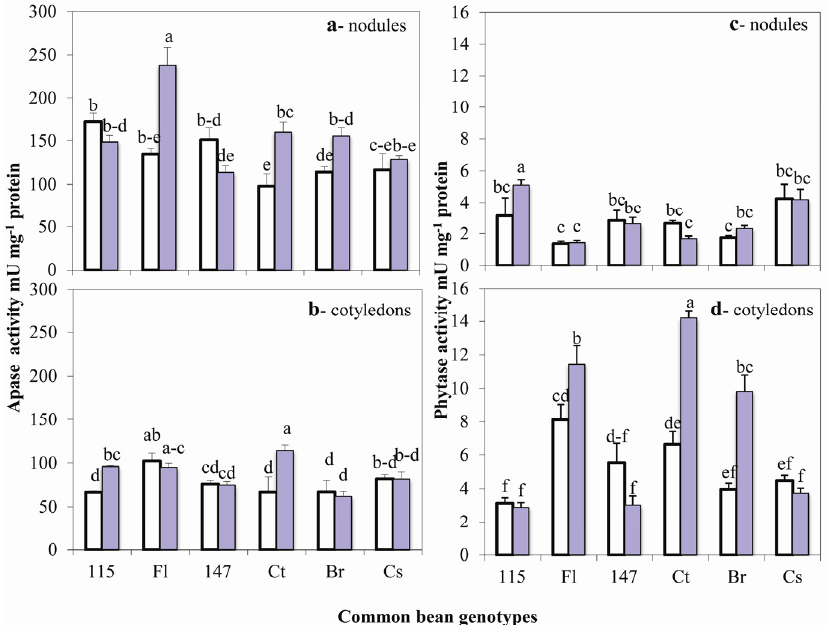
Figure 4. APase and phytase activities in nodules ( a and c ) and cotyledons ( b and d ) of six common bean genotypes grown under sufficient P (empty bar) versus low P (filled bar) soil. Data are means ± se of six replicates harvested at flowering